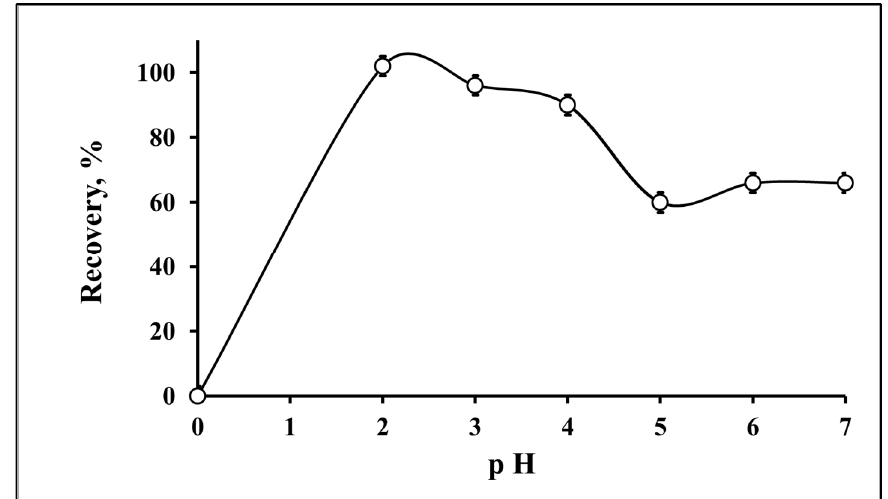
Figure 1. Evaluation of pH for the recovery of Pb(II) by DES-ME ( n = 3).